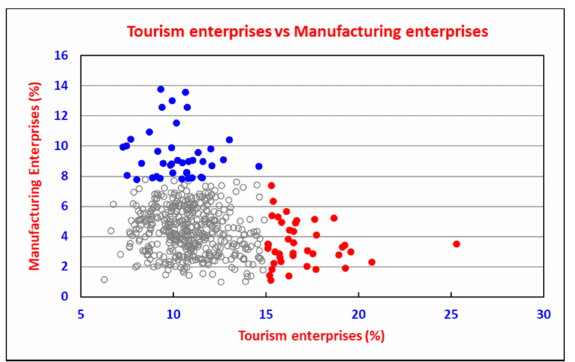
Figure 11. A comparison of 40 micropolitans with the strongest tourism sectors (red dots) and 40 mi- cropolitans with the strongest manufacturing sectors (blue dots). Strength is based on the percentage of either tourism or manufacturing enterprise numbers relative to total enterprise